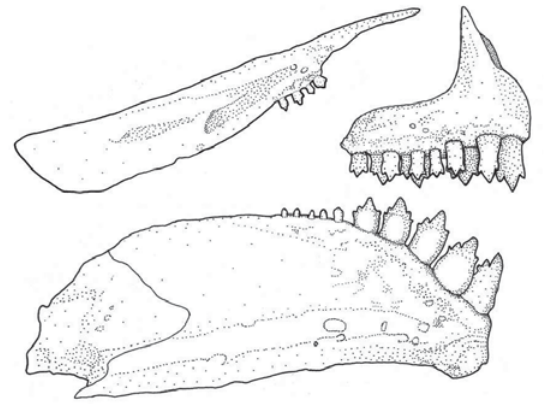
Fig. 2. Moenkhausia diamantina , paratype, LIRP 768, 47.3 mm SL, premaxillary, maxillary and dentary; left side, lateral view (maxillary and dentary) or frontal view (premaxillary). Scale bar = 1 mm.